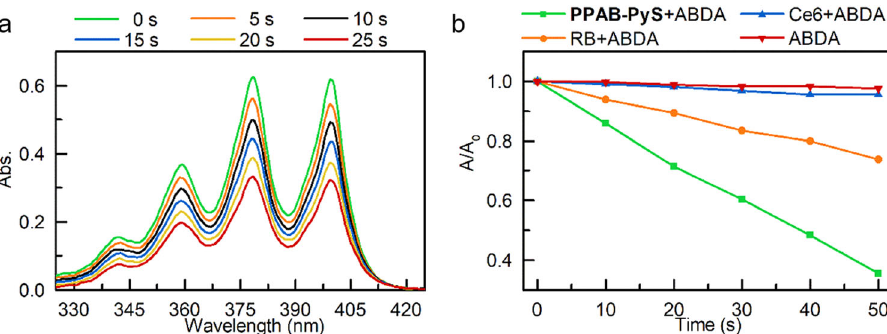
Fig. 3 The generation of singlet oxygen by PPAB-PyS. a UV – vis spectra of ABDA with PPAB-PyS under white light irradiation in MeCN/water mixtures with f w = 99%. b Plot of relative absorbance of ABDA without and with different PSs under white light irradiation, where A 0 and A are the absorbances of ABDA at 378 nm before and after white light irradiation, respectively. [PS] = 5 × 10 − 6 M, [ABDA] = 5.0 × 10 − 5 M.